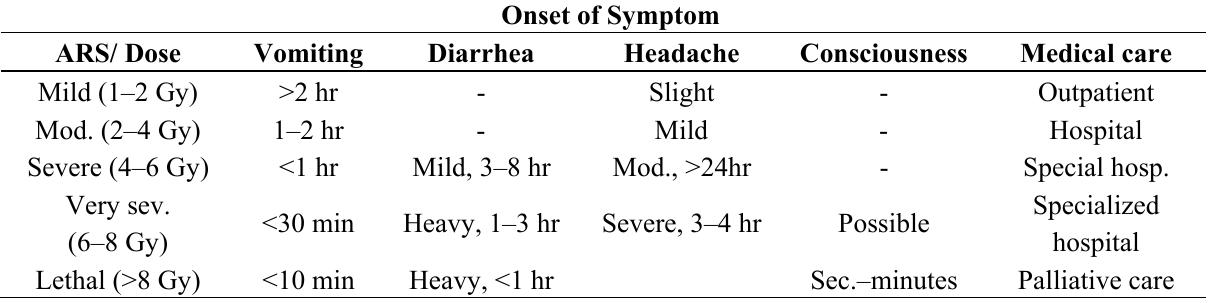
Table 3. Signs and symptoms correlated with absorbed radiation dose